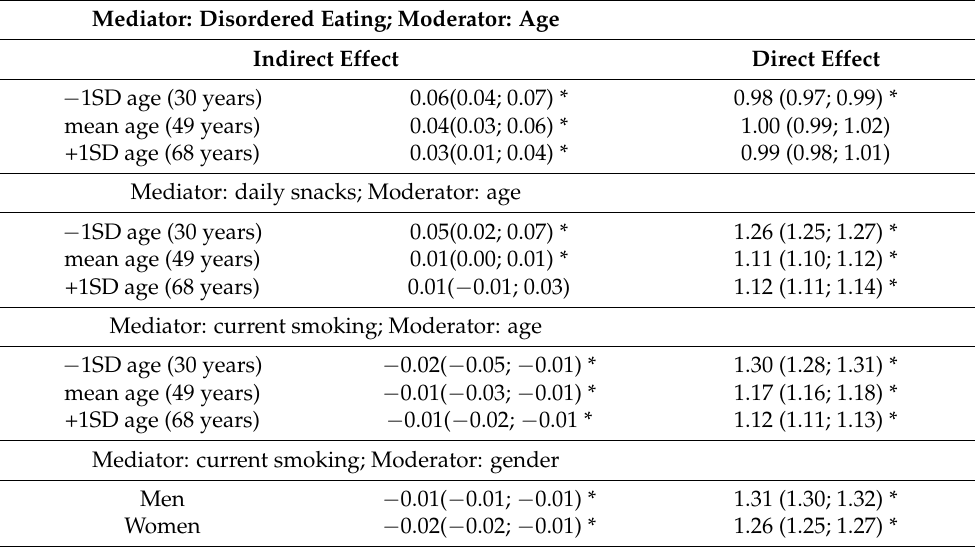
Table 4. Standardized indirect effect for lifestyle mediation with significant moderated mediation by age or gender in the relation between mental health (anxiety and/or depression) and excess